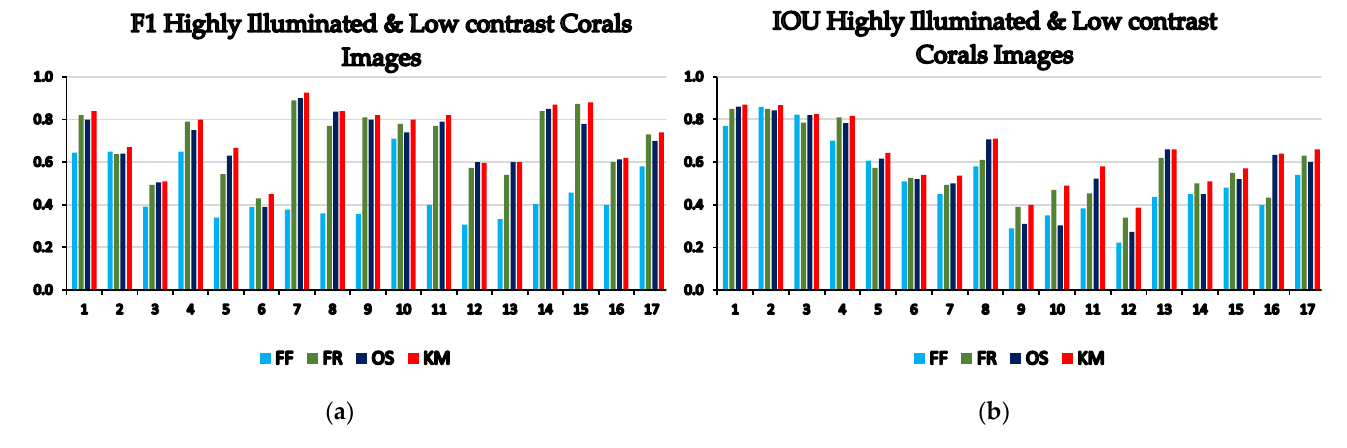
Figure 21. The results of evaluating the tested segmentation algorithms using highly illuminated and low contrast corals images. Images (1 – 8) had two categories, and (9 – 17) had three categories: